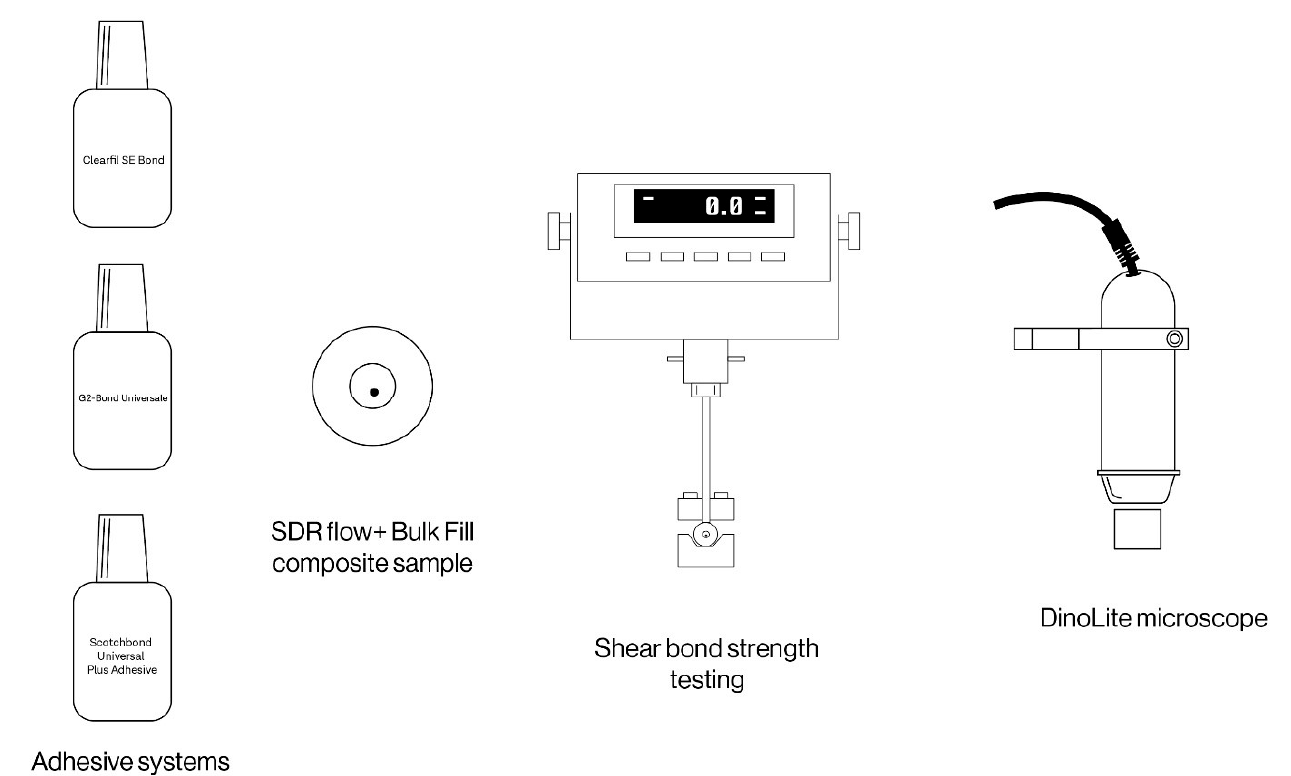
Figure 2. Shear bond strength testing and surface microanalysis.